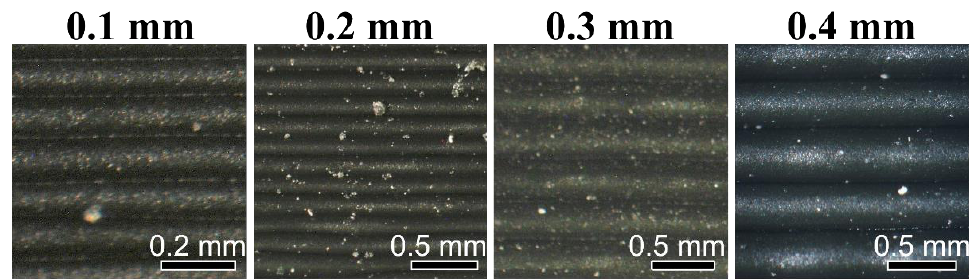
Figure 13. As-printed surfaces of Premium ABS as a function of layer height.